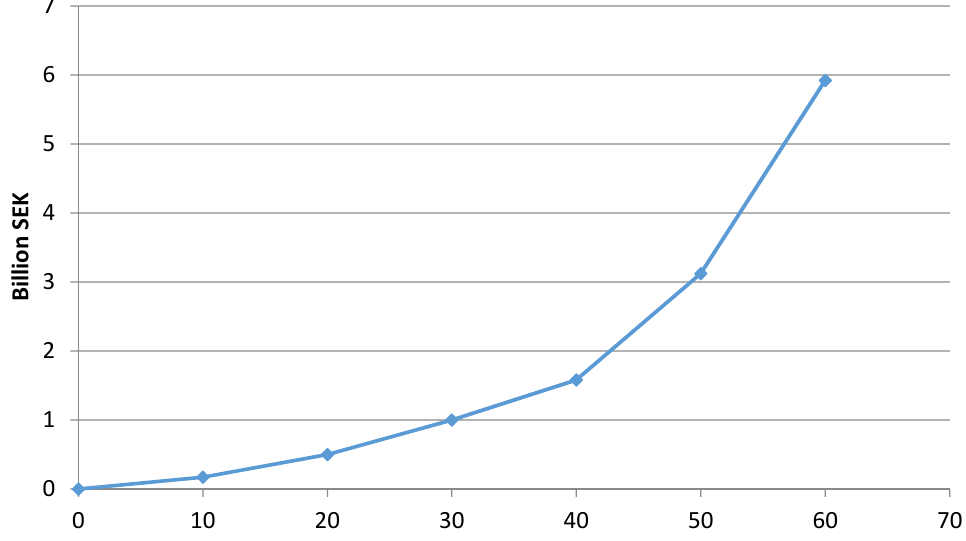
Figure 3. Value of the forest for nutrient sequestration in reducing nitrogen and phosphorus loads from the Stockholm-Stockholm-Mälar region to the Baltic Proper in